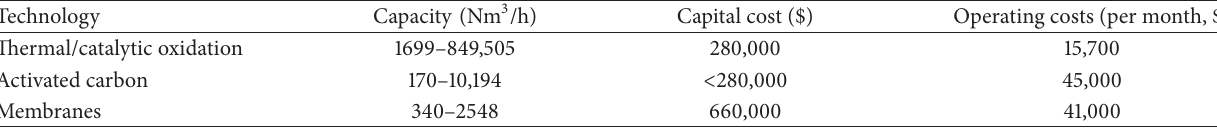
Table 14: Economical study for removal of VOCs (1000ppm) from air to treat 850 Nm 3 /h by different technologies [27]. Technology